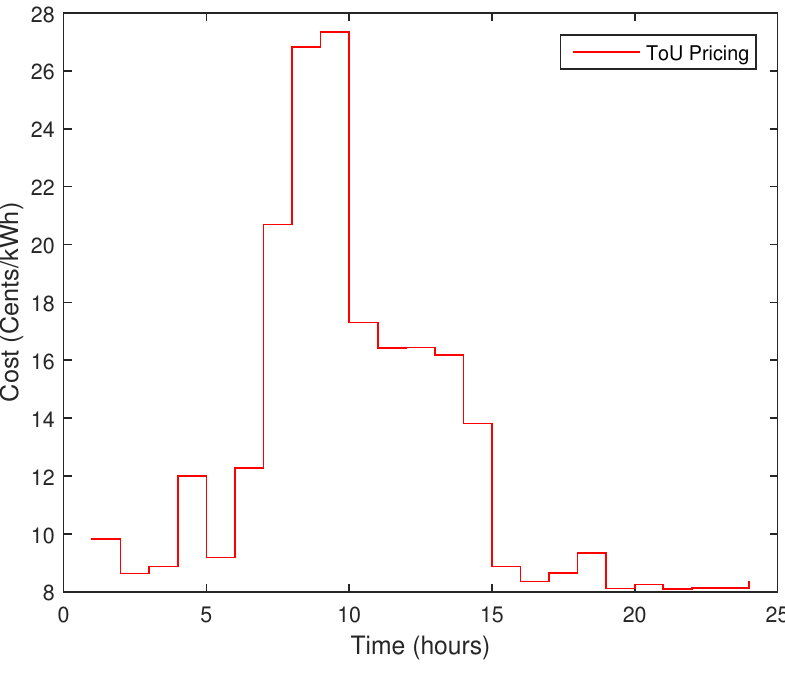
Figure 6. Time of use (TOU)